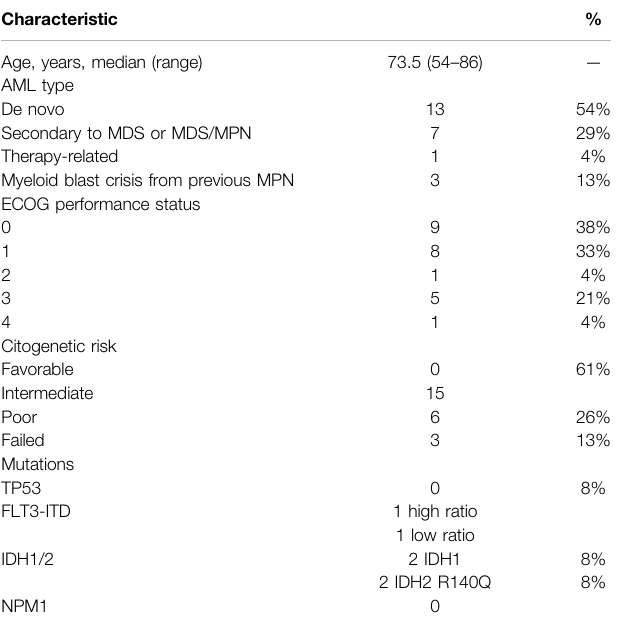
TABLE 1 | Patient demographics and clinical characteristics at baseline.